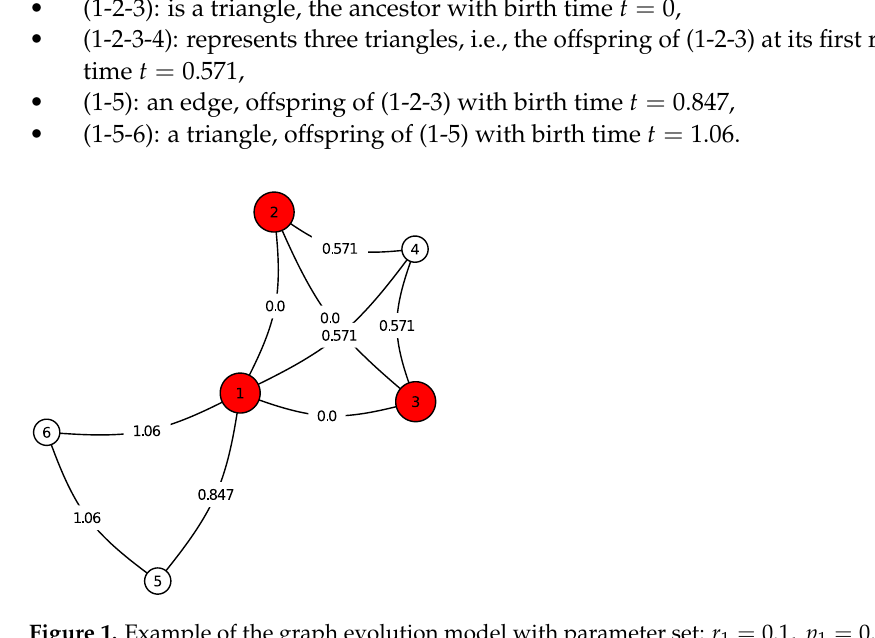
Figure 1. Example of the graph evolution model with parameter set: r 1 = 0.1, p 1 = 0.4, p 2 = 0.2, b = 0.1, c = 0.1.